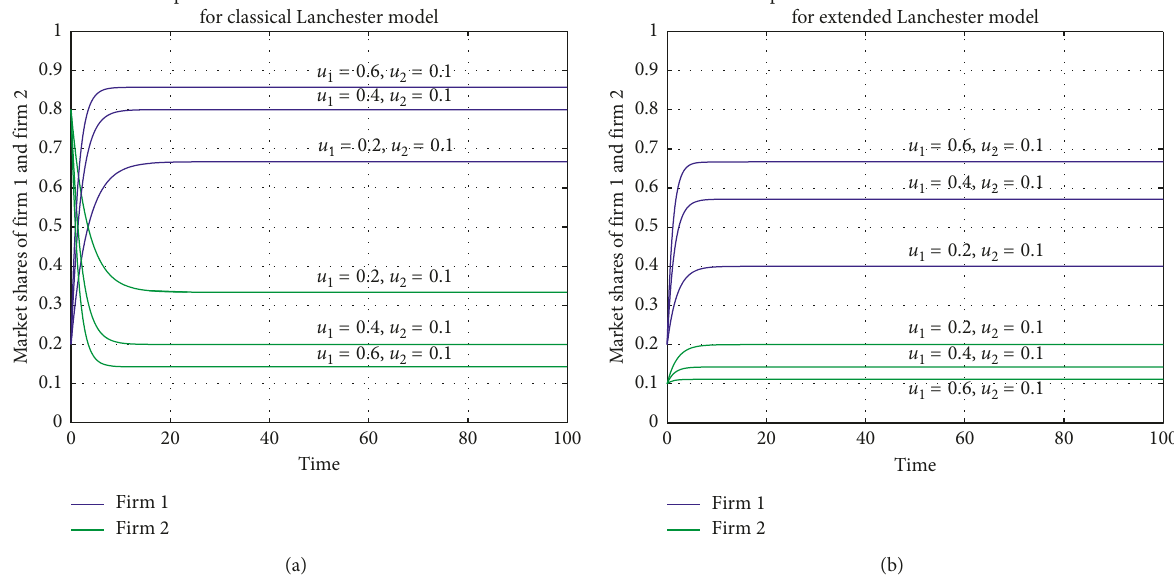
Figure 2: Evolution of market shares of firms x � 0 . 2 , 0 . 4 , 0 . 6, for firm 1 and c � 0 . 1 for firm 2 for (a) classical Lanchester model for x c 1 2 ( 0 ) � 0 . 2, x ( 0 ) � 0 . 1 and λ � 0 . 2. Note that in the classical Lanchester model the market shares are always on the line undecided users for x 1 2 + x � x 1 2